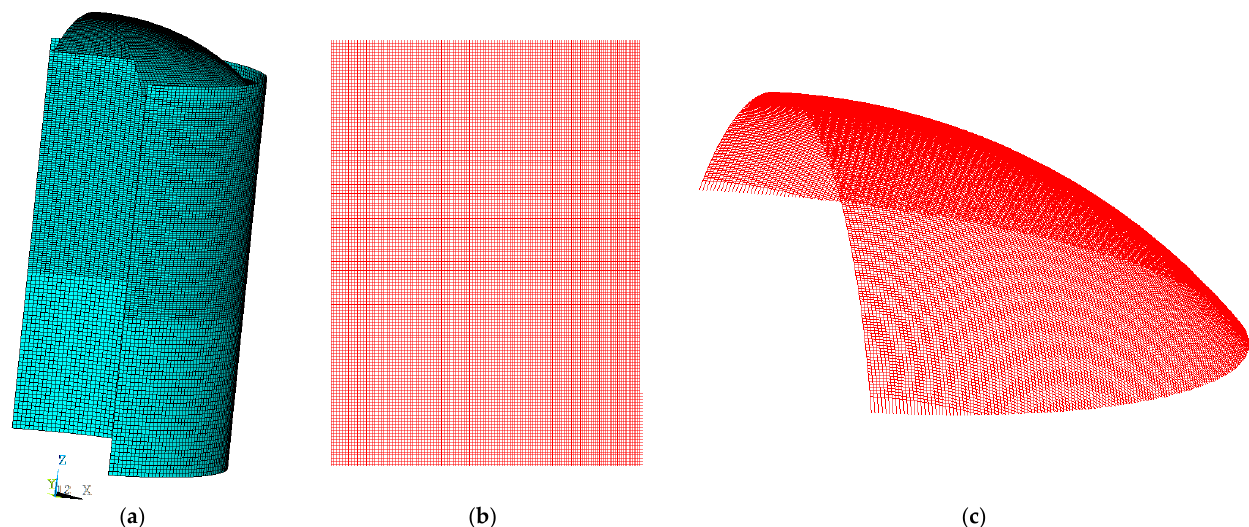
Figure 3. Finite element model of full SC containment. ( a ) Overall model; ( b ) Load area; ( c ) Symmetric restriction.